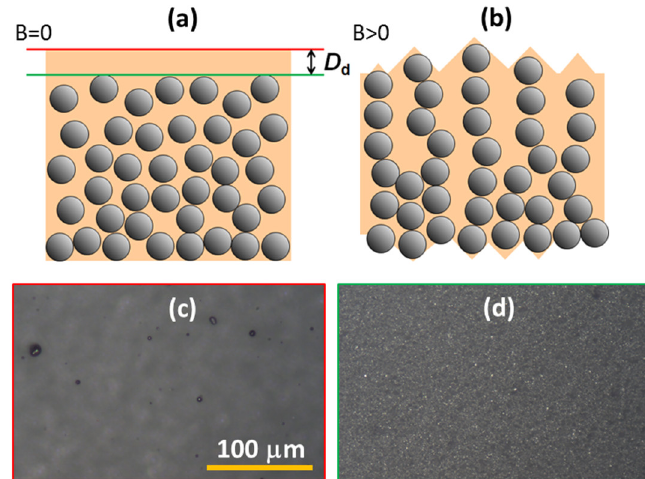
Figure 9. A schematic drawing of the MAE structure in ( a ) the absence of magnetic field and ( b ) in the applied magnetic field oriented perpendicular to the surface. ( c ) An optical microscopy image of the air-MAE surface with some trapped air bubbles and ( d ) of the underneath image plane located about 20 µ m below the air-MAE interface, in which single carbonyl iron microparticles can be seen.